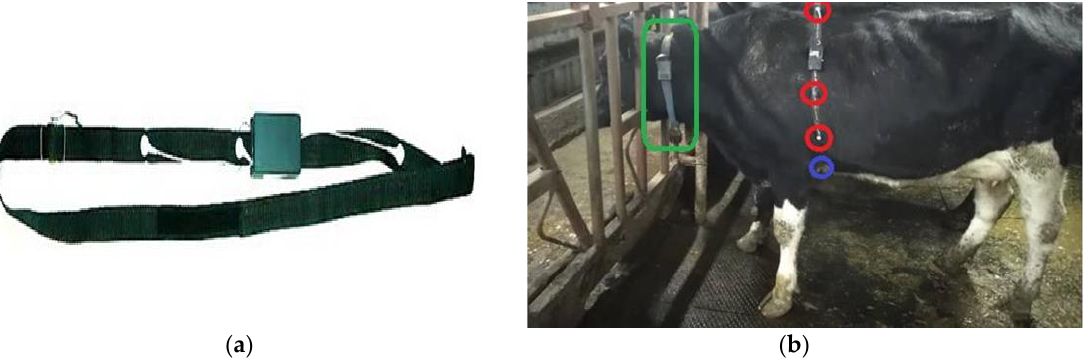
Figure 2. Placing the experimental sensor: sensor electrodes ( a ) were placed on the cow at the gogo, on the left side of the abdominal wall ( b ).